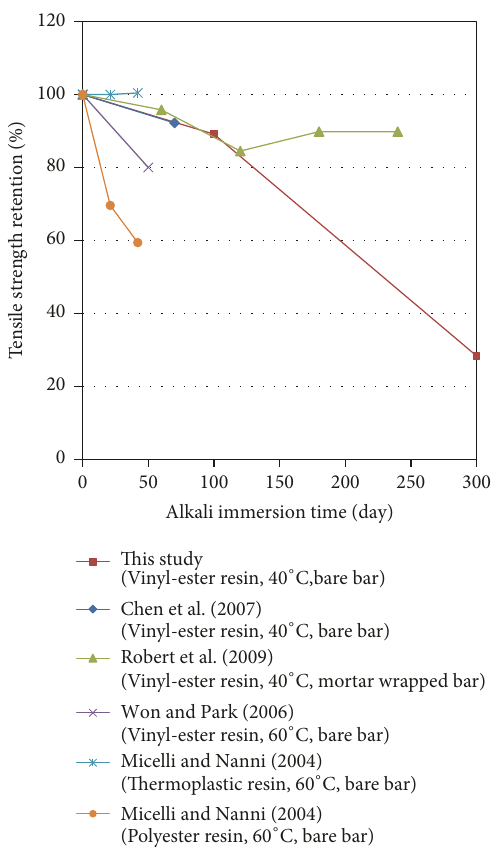
Figure 7: Accelerated aging test results of Ref and comparisons with those presented in referred